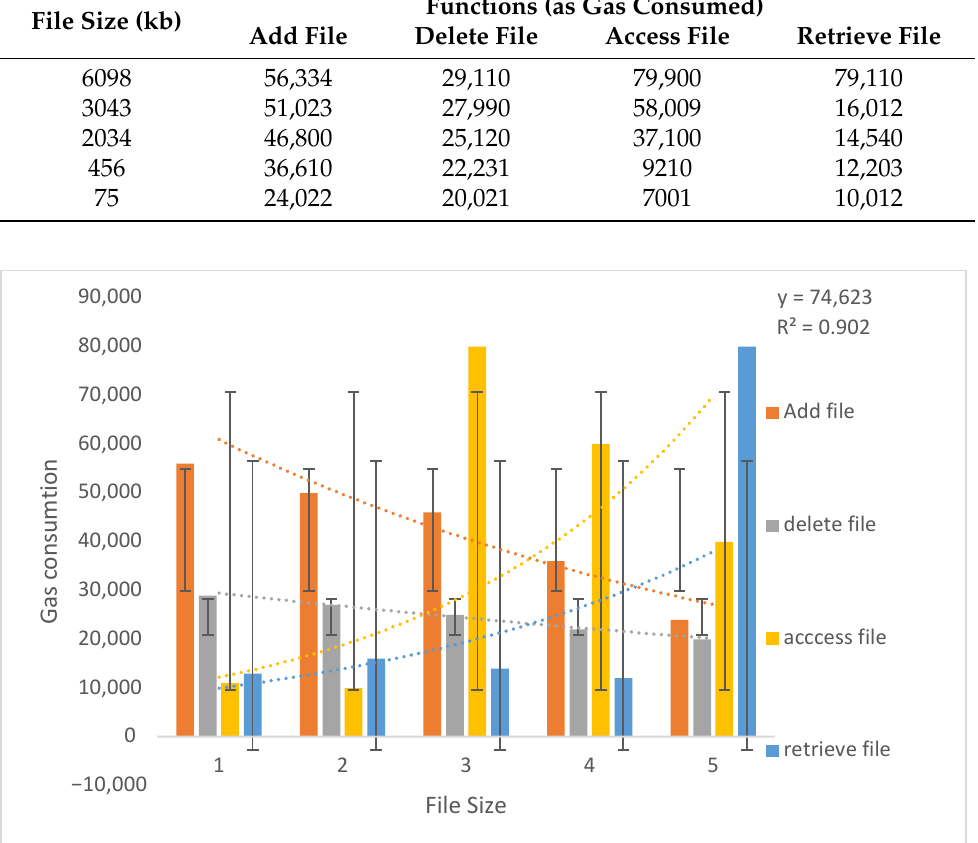
Figure 12. Gas consumption cost to add, delete, access and retrieve